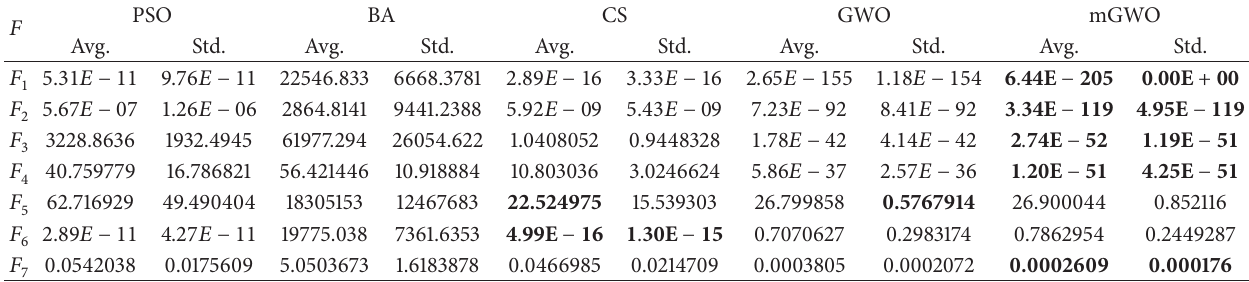
Table 5: Results of unimodal benchmark